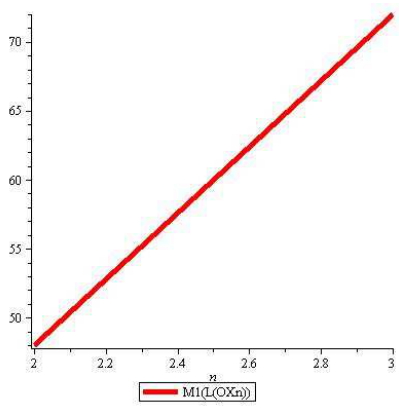
Figure 4: Graph of first Zagreb index of line graph